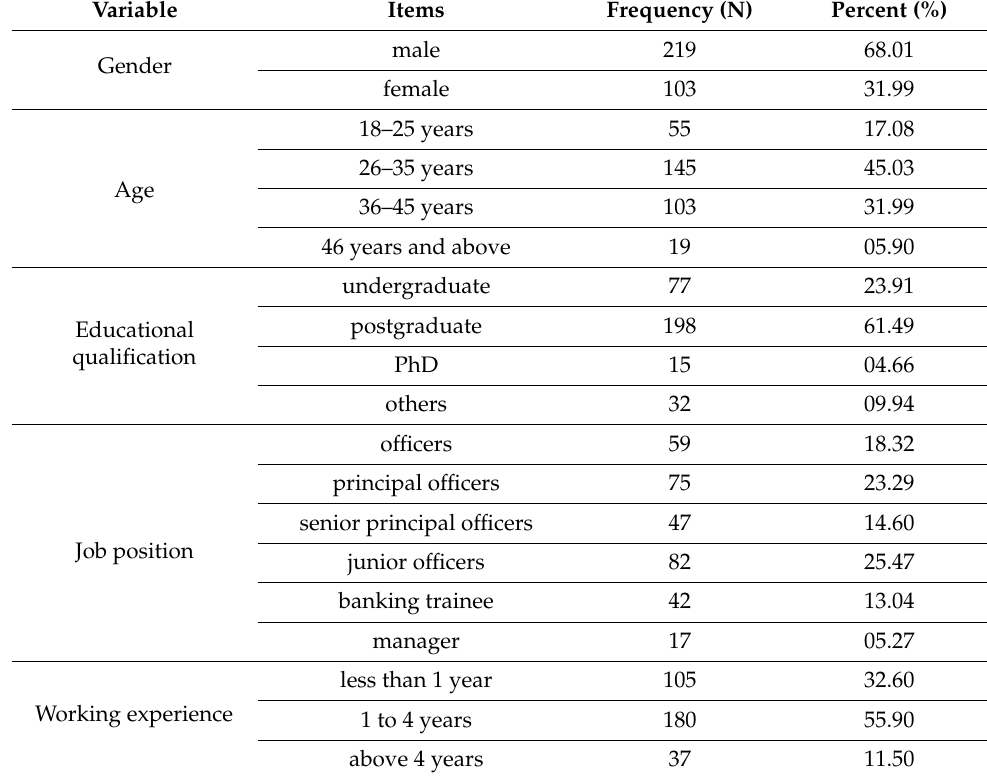
Table 3. Demographic information of the respondents.